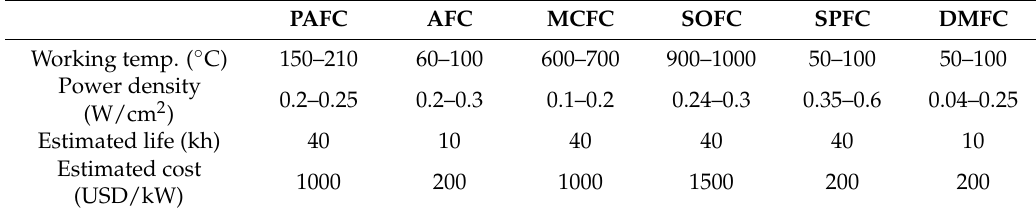
Table 11. Comparison of different fuel cell configurations. Data from